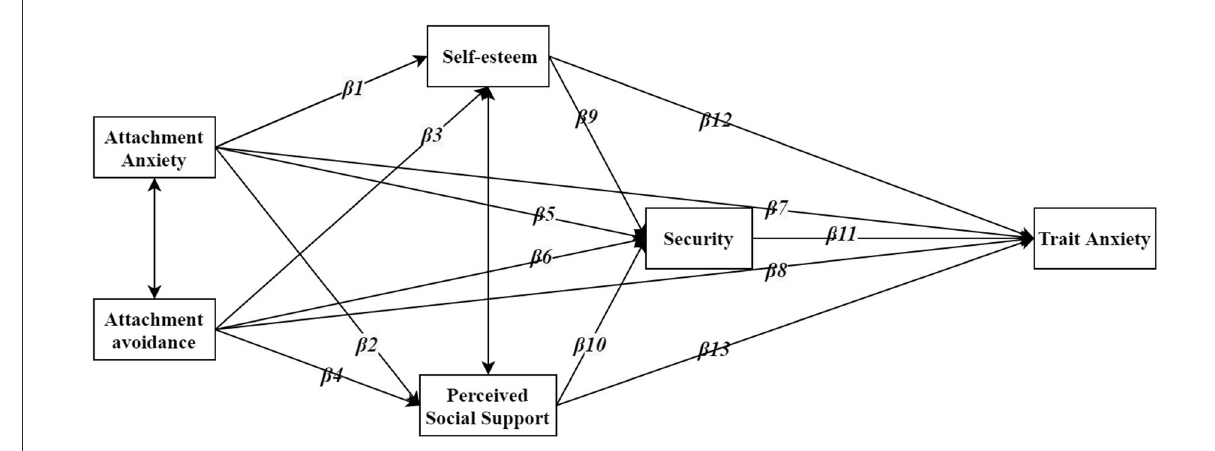
FIGURE1 Research hypotheses